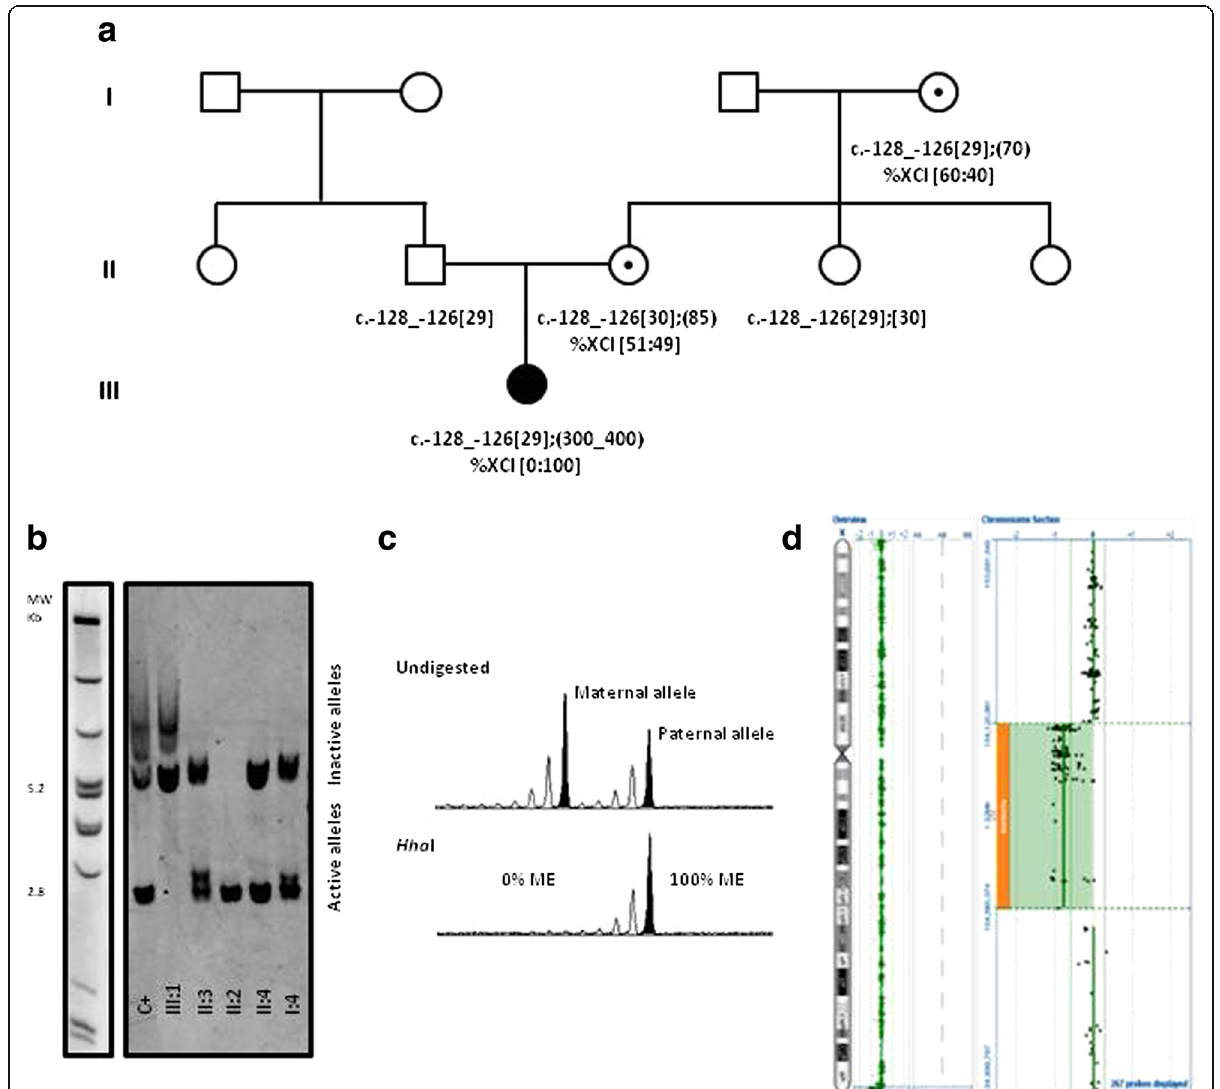
Fig. 1 Pedigree and summary of overall laboratory findings. a – Proband ’ s pedigree (III:1) showing FMR1 genotyping and XCI ratio results. b – Southern blot analysis using GLFXDig1 probe (Gene Link TM , Hawthorne, NY, US) and DNA Molecular Weight Markers II and III, DIG-labeled from Merck KGaA, Darmstadt, Germany; Female control with a full mutation (C+) c.-128_-126[30];[250_400]; Proband III:1 showing complete absence of normal, active FMR1 allele. Premutation carriers (II:3 and II:4) show four fragments corresponding to the normal active, expanded active (2.8 kb and above) and normal inactive and expanded inactive (5.2 kb and above) alleles [21]. c - HUMARA results obtained in proband ’ s leukocytes (III:1) [10]. Hha